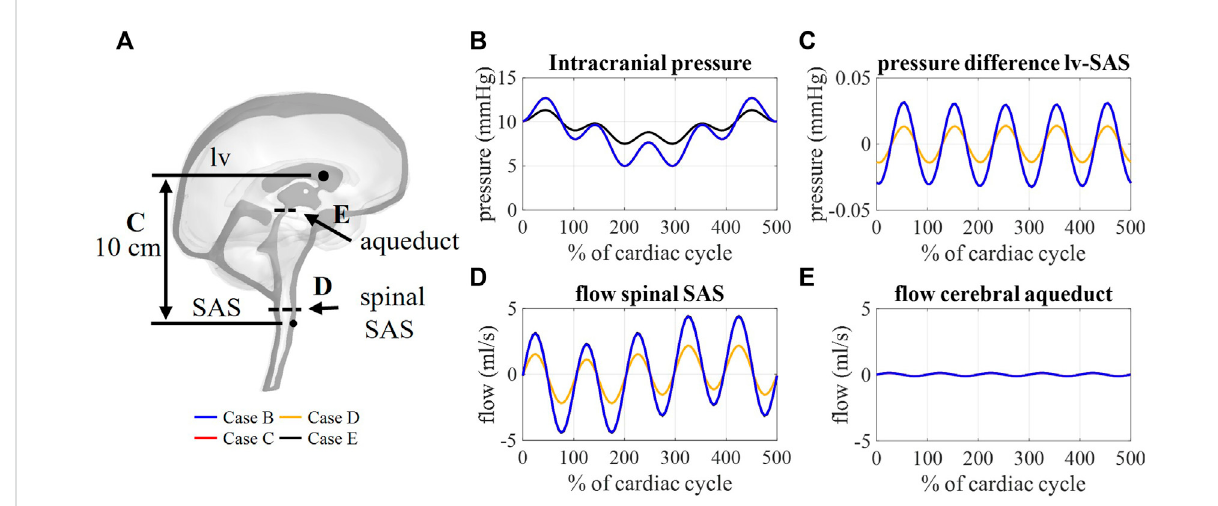
FIGURE 8 (A) Sagittal cross-section CSF depicting the location of aqueduct cross-section B, spinal SAS cross-section D, and 10 cm distance between a point in lateral ventricles (lv) and spinal SAS (SAS) (C) . Simulation results for cases B, C, D, and E: (B) Intracranial pressure corresponding to interstitial